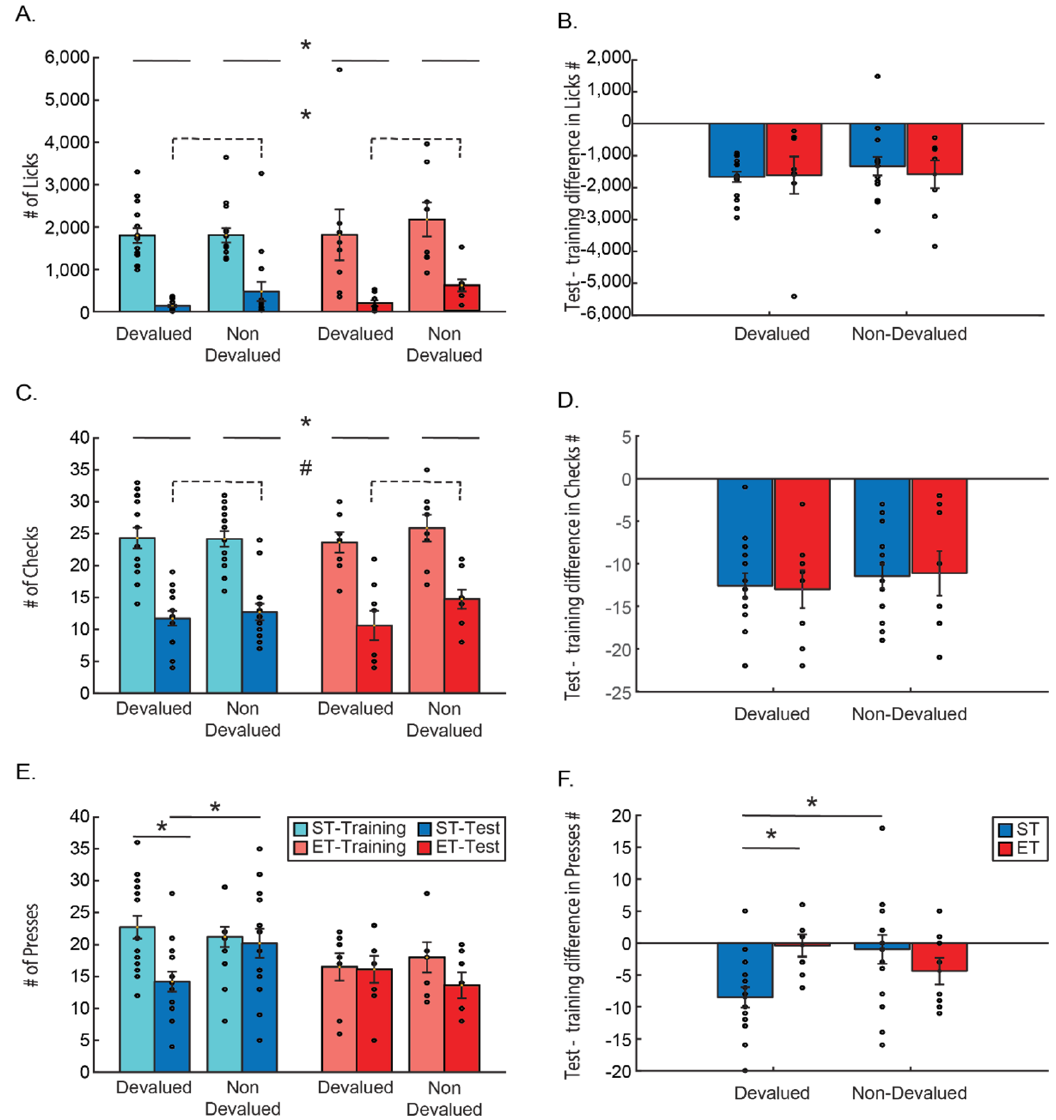
Figure 2. The task behaviors in the test following devaluation training. All following figures are bar plots with error bars (standard error) overlaid with the dots of raw data of each mouse. Blue represents the short training group (ST) and red represents the extended training group (ET). In each group, the lighter color represents the last day of training and the darker color—the test. Asterisk represents significance of p < 0.05. Hash (#) represents a statistical trend (0.1 > p > 0.05). Each figure on the left ( A , C , E ) shows the full comparison of each behavior between training groups, reward type, and time. Figures ( A , C , E ), show a comparison of the number of licks, magazine checks, and lever presses, correspondingly. In each figure, the data are shown for both the ST and ET groups, for the devalued and non-devalued rewards, and are presented separately for the last day of training and test sessions. Full lines represent the three-way ANOVA effects and dashed lines—two-way ANOVA effects. Figures ( B , D , F ) show the comparison of the differences (subtraction) between the test day and the last day of training in each mouse’s behavior between training groups and reward type. ( A , B ) presents the number of licks. ( C , D ) presents the number of magazine checks. ( E , F ) presents the number of lever presses.